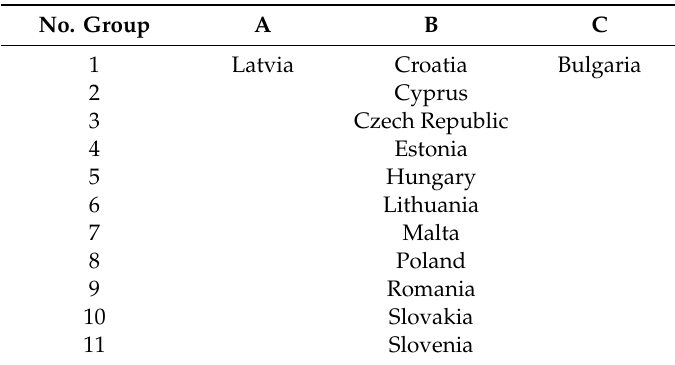
Table 9. Clusters for IREN in 2004.